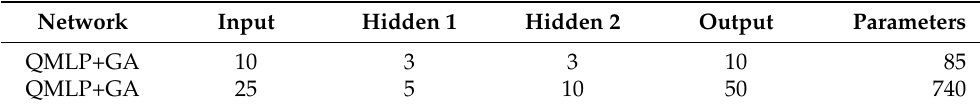
Table 2. Neural network topology for chaotic prediction. Network Input Hidden